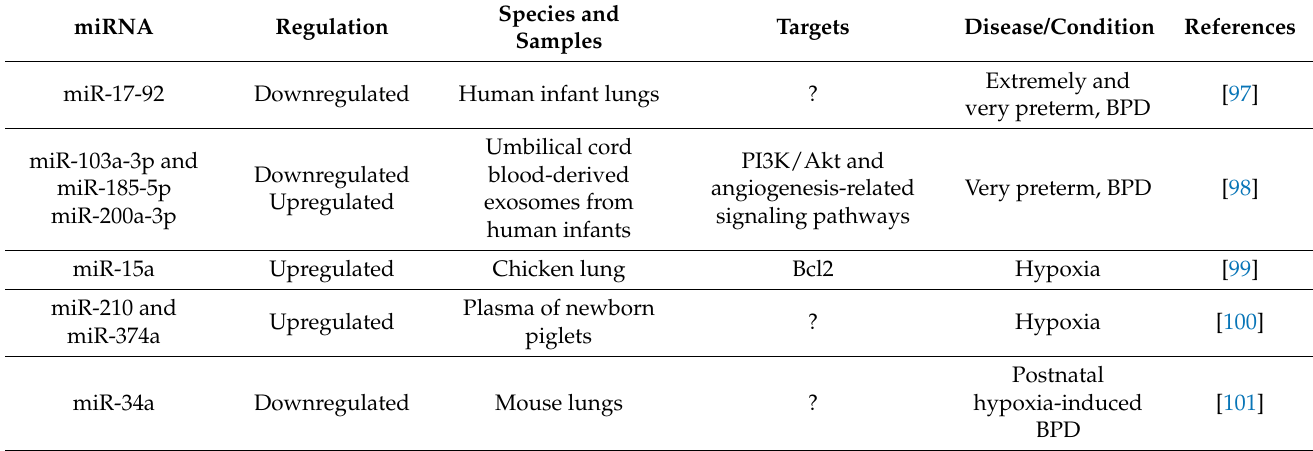
Table 2. MiRNAs in hypoxia and